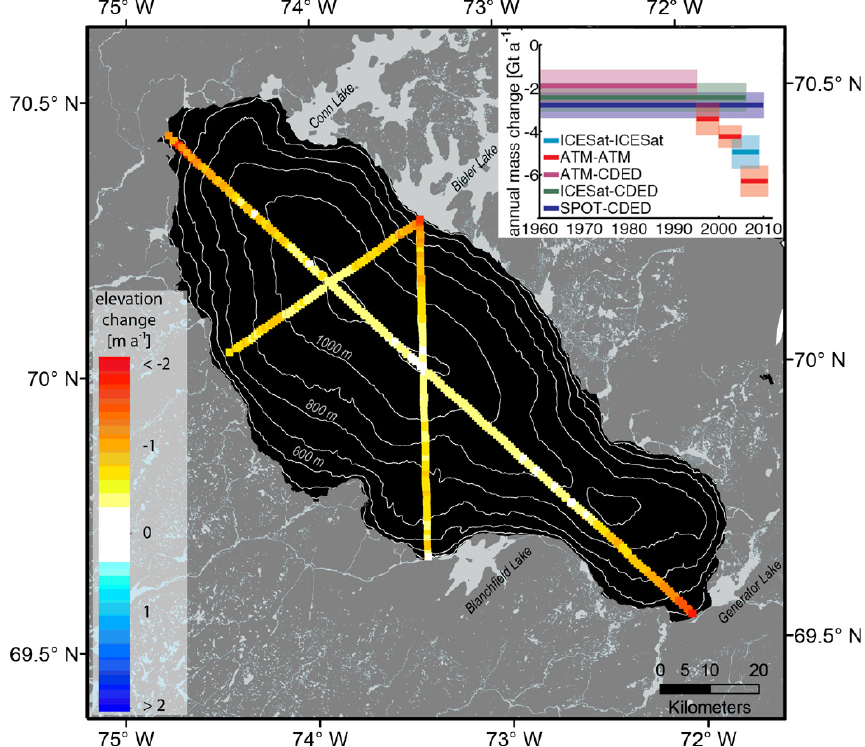
Fig. 6. Elevation change rate (ma − 1 ) of the Barnes Ice Cap between spring 2000 and spring 2005 as determined from repeat airborne laser altimetry. Inset graph shows annual mass change of the Barnes Ice Cap determined over varying time periods with corresponding 95% confidence intervals. A mass change of 1Gta − 1 =169kgm − 2 a − 1